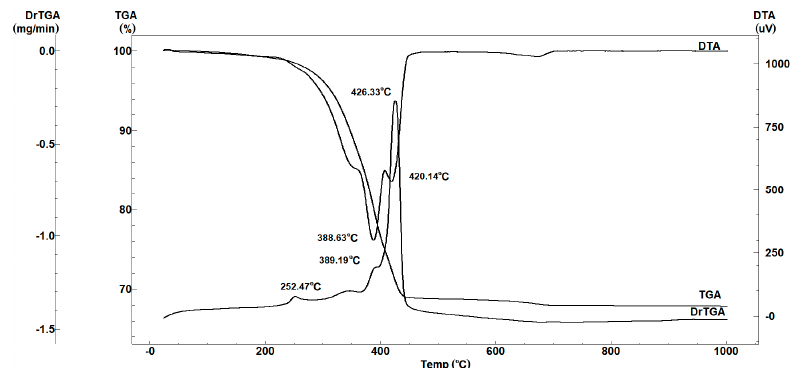
Thermogravimetric and di ff erential thermal analysis results of the resin modified tricalcium